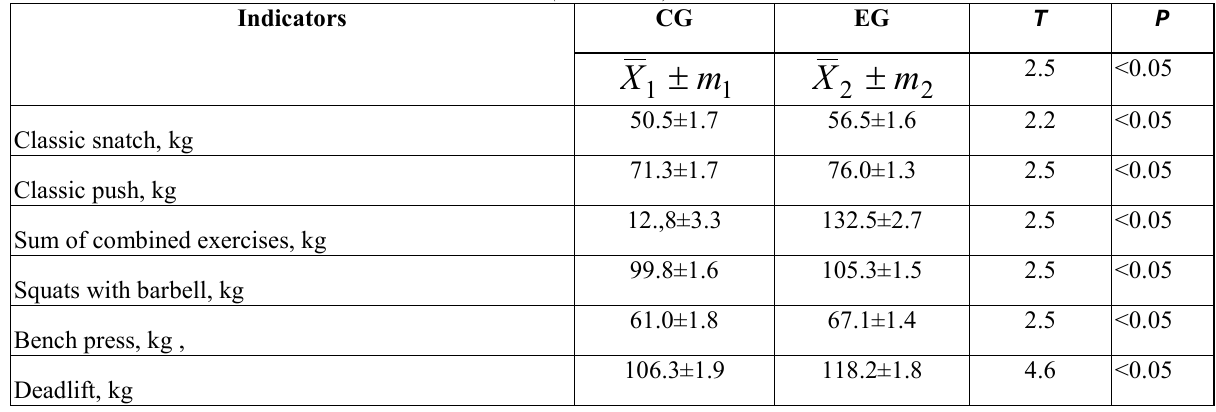
Mean indicators of results’ increment of competition and special preparatory exercises, fulfilled by junior weight